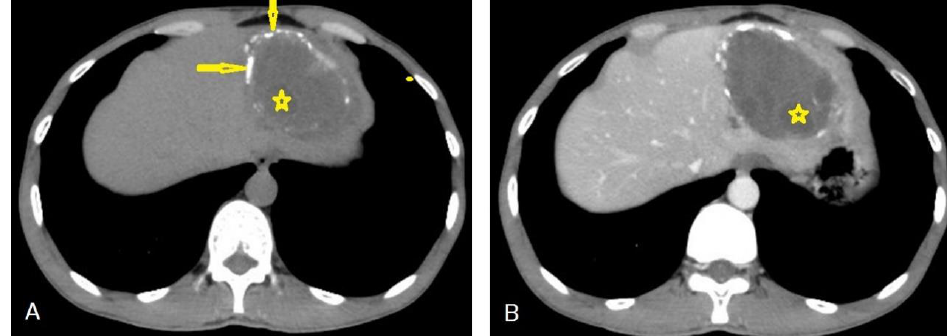
Figure 11. Selected axial non-enhanced ( A ), and contrast-enhanced ( B ) CT images of the abdomen of an adult male patient showing a well-circumscribed hypodense cystic lesion with multiple daughter cysts inside it (stars), with stippled calcification of the wall (arrow), and with no enhancement after contrast administration. Picture of hydatid cyst Type IIC.